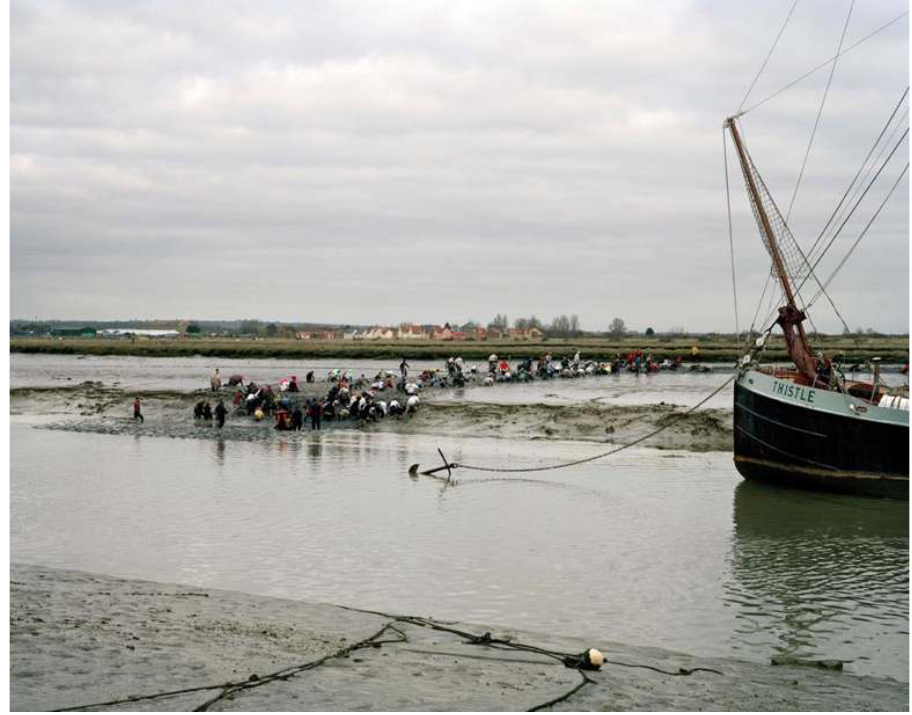
Figure 4: Simon Roberts, ‘Mad Maldon Mud